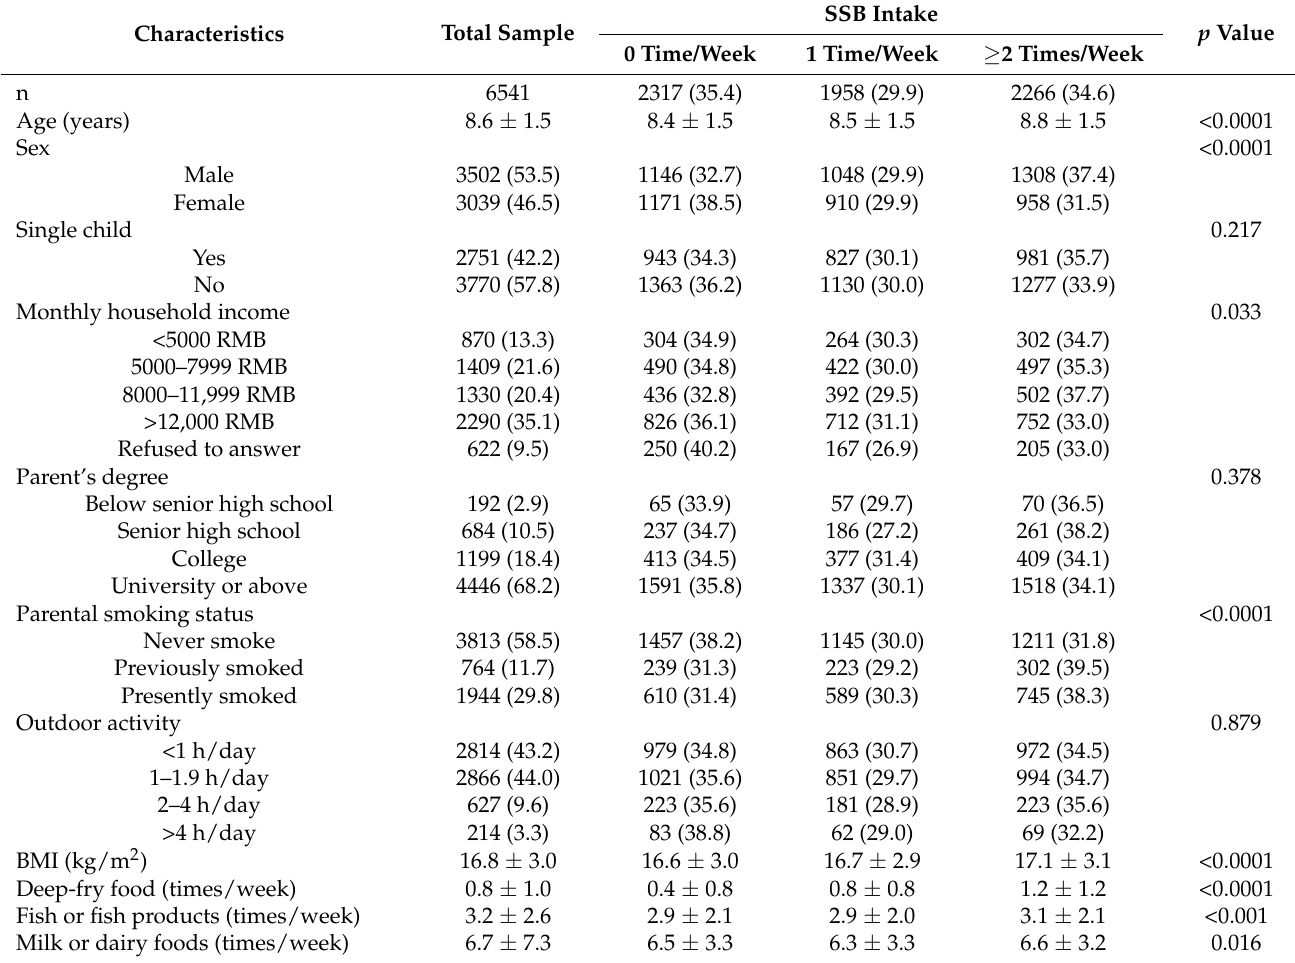
Table 1. Baseline characteristics according to SSB